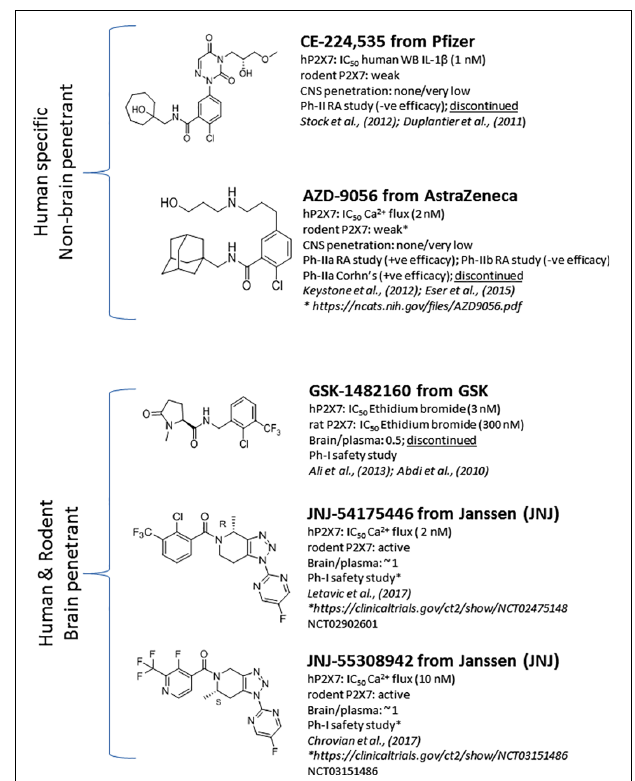
FIGURE 1 | P2X7 antagonists that transitioned into clinical